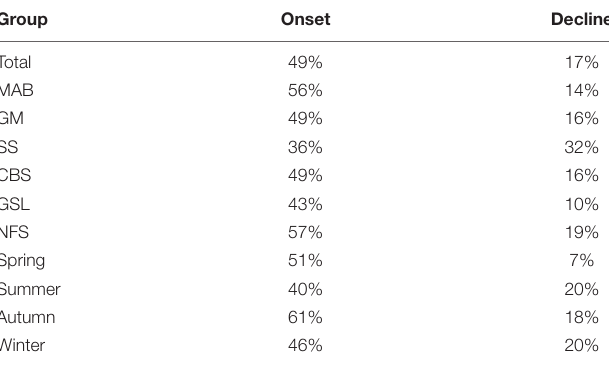
46% 20% The columns show the grouping of the MHWs and then the percentage of the onset or decline of MHWs where the majority of the corresponding change in SSTa could be attributed to air–sea heat flux. Note that these statistics are only calculated on MHWphases(onset/decline)of3daysinlengthorgreater.Theregionabbreviations are given in Figure 1